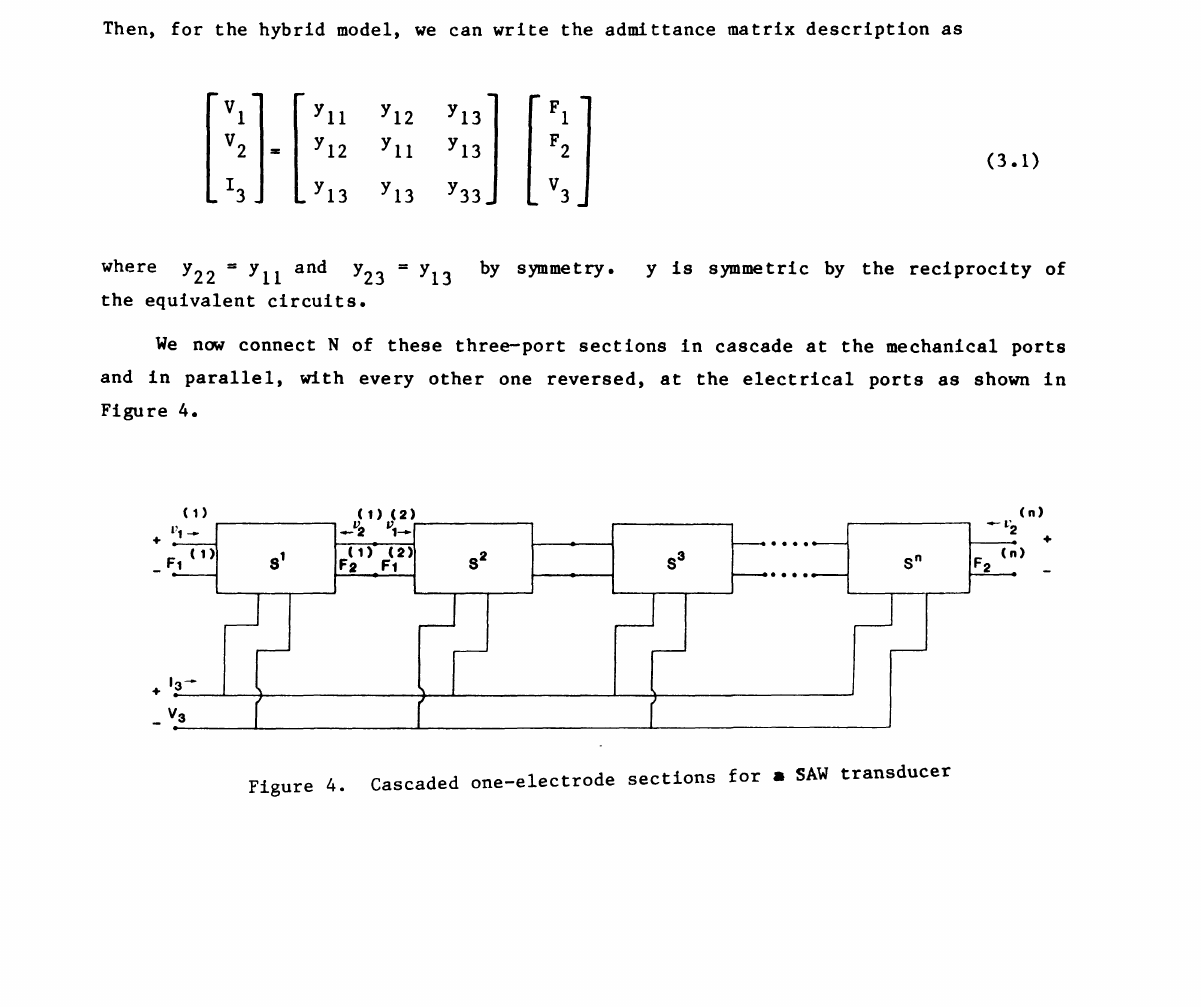
Figure 3. Block-diagram of a three-port